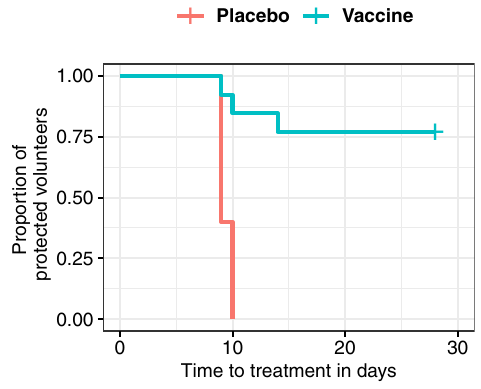
Fig. 4 Kaplan – Meier plot of time from infection to treatment initiation. The overall time to treatment (in days) after injection of 3.2 × 10 3 PfSPZ Challenge (onset of CHMI) is presented for both the placebo ( n = 5) and the vaccinated ( n = 13) groups. The cross represents the censoring event at the end of the follow-up period of the speci fi c CHMI (day 28 after CHMI). Two volunteers receiving placebo withdrew consent before CHMI; these individuals were not included in the survival analysis. Time to treatment: treatment was initiated at time of parasitemia. Parasitemia as the CHMI endpoint was de fi ned as at least one qPCR result above 100 parasites/ml among three positive results at least 12 h apart or as a positive thick blood